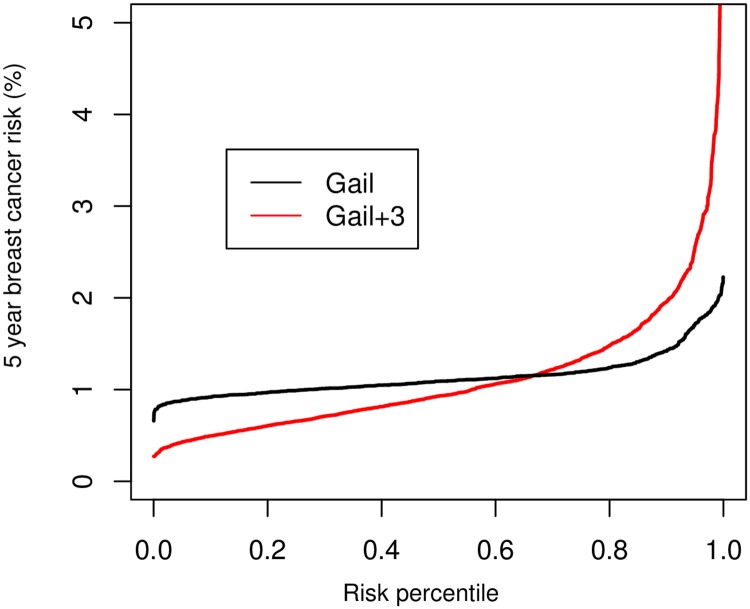
Predicted 5-year risk of breast cancer by risk score percentile comparing the Gail model to the Gail model plus 3 biological markers among postmenopausal women not using hormone therapy.In the figure, the y-axis was truncated at 5% because very few (0.69%) 50-year-old women were at 5-year risk at or greater than 5% to 12% (the maximum risk observed in our population) using the Gail + polygenic risk score + mammographic density + hormones (Gail + 3) model. The x-axis represents the risk percentile, ranging from >0 to 1 (i.e., a rank ordering of risk from >0% to 100% for the population).